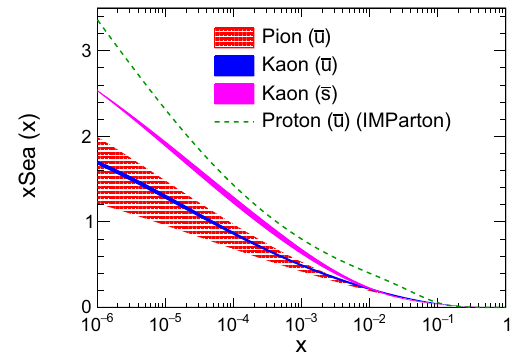
rule and the perturbative QCD predictions. And the power law behavior at small x is in well agreement with Regge theory calculations with the double logarithmic resummation (cid:5) (cid:4) (cid:5) (cid:4) (cid:6) x (cid:7) , x 3 x 2 , , and compare them with LQCD